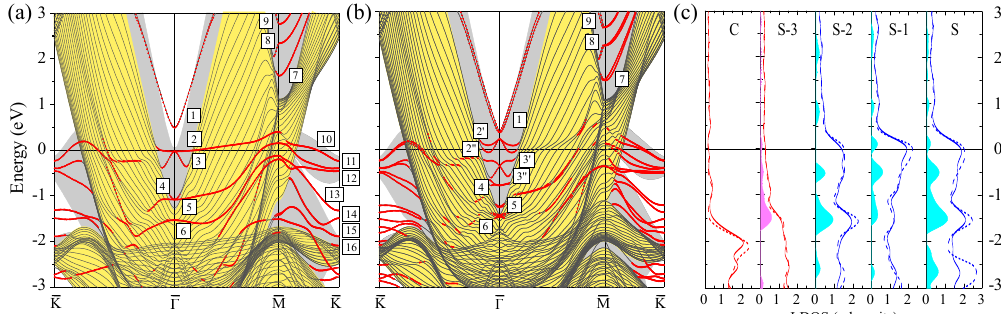
Figure 10. The electronic structure of the 3 ML-Pt/Au(111) surface calculated without ( a ) and with ( b ) spin–orbit interaction. The surface and quantum-well states and resonances are indicated by red dots. The states discussed in the text are labeled by symbols. In ( c ), the layer density of states is shown for three Pt, top and central Au atomic layers. Blue and pink regions show the excess of LDOS in, respectively, Pt and Au layers in comparison with the corresponding bulk